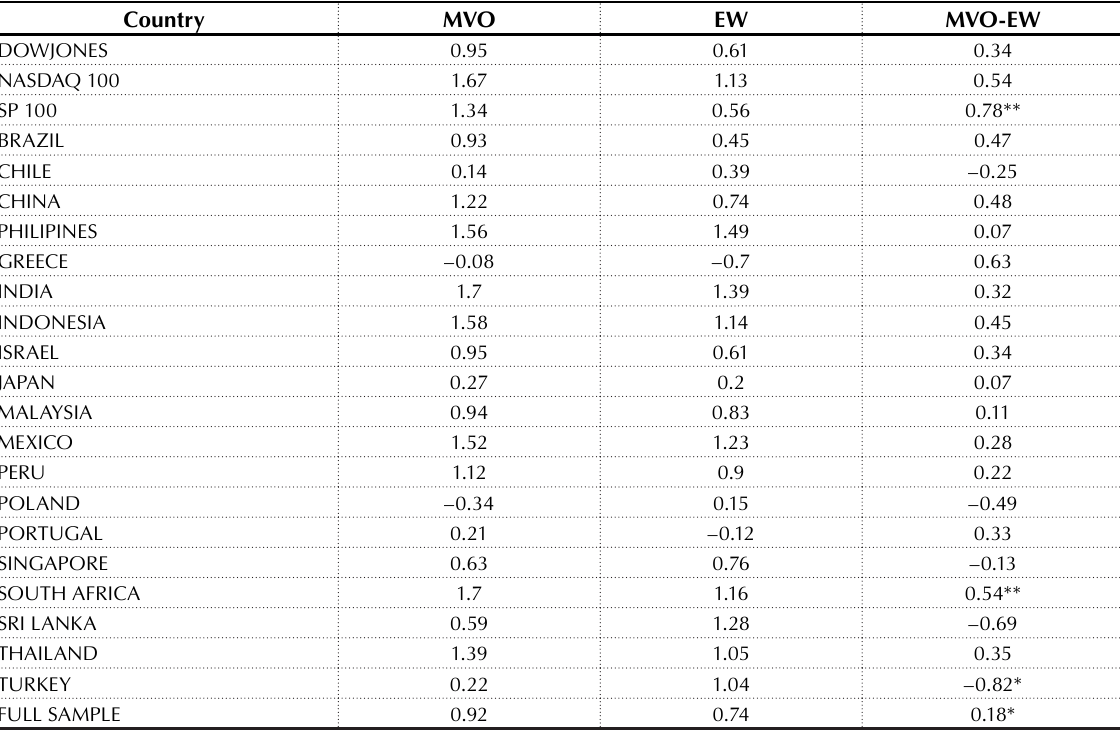
Table 9. Comparison with performance of EW